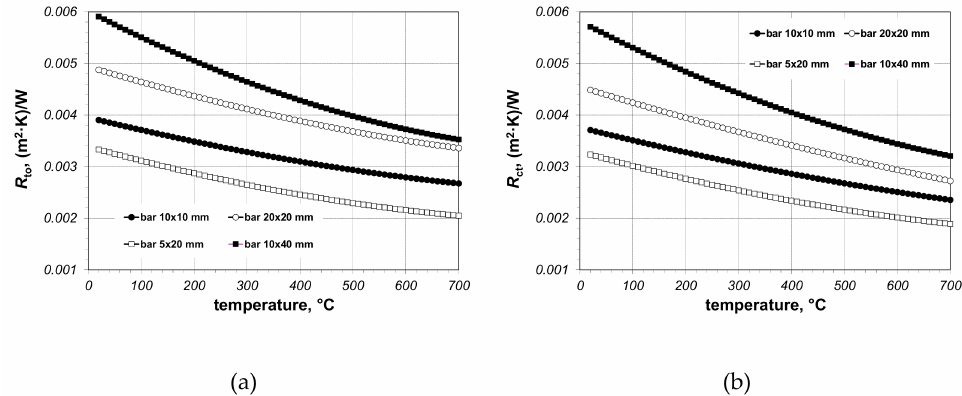
Figure 7. ( a ) Smoothed results of measurements of the R to resistance of beds of bars and ( b ) the results of calculations of the R ct resistance of beds of